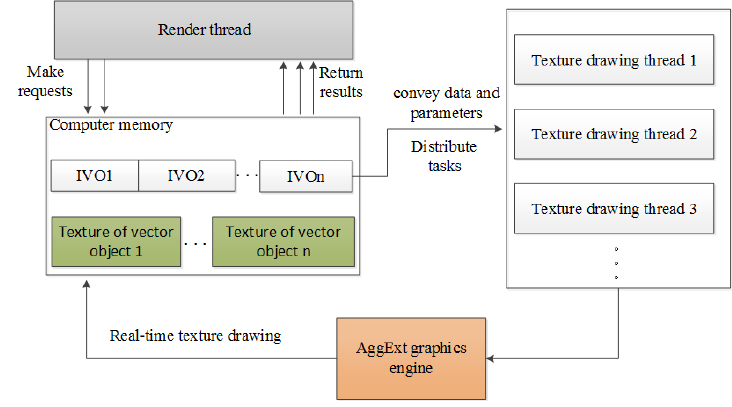
Figure 4. Real-time texture drawing framework for vector